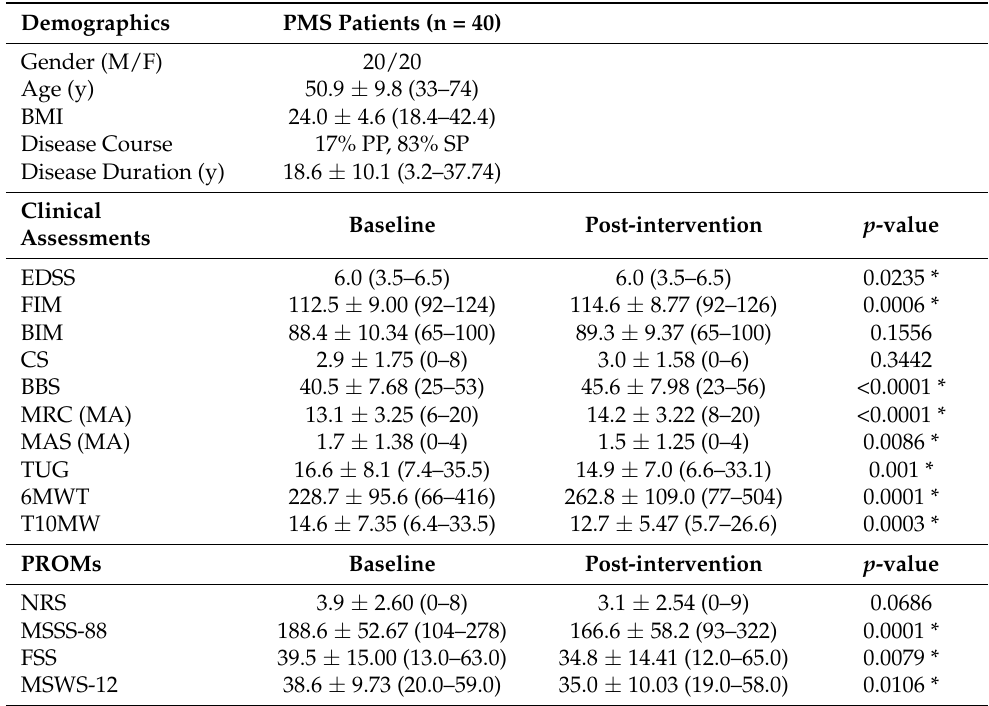
Table 1. Patient demographics, clinical assessments, and PROMs at baseline and at the end of the intensive neurorehabilitation